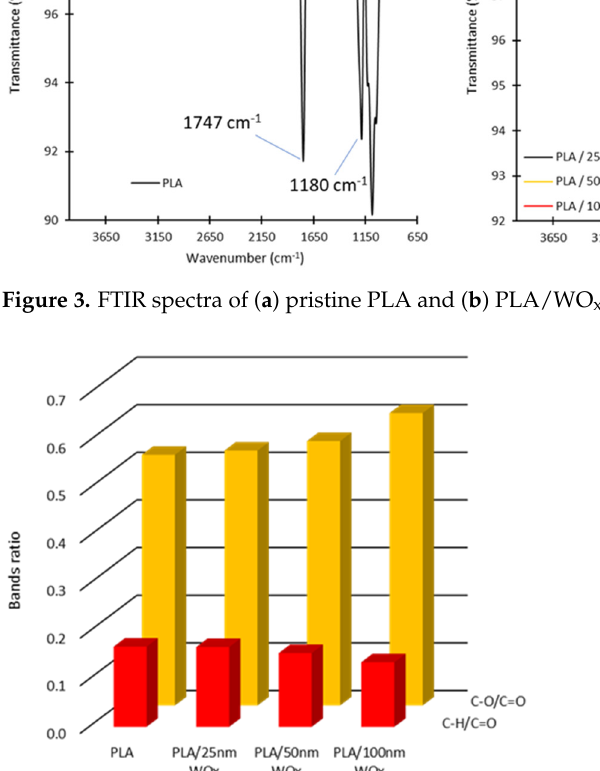
Figure 4. C-H/C=O and C-O/C=O band ratios for pristine PLA and PLA WO x .